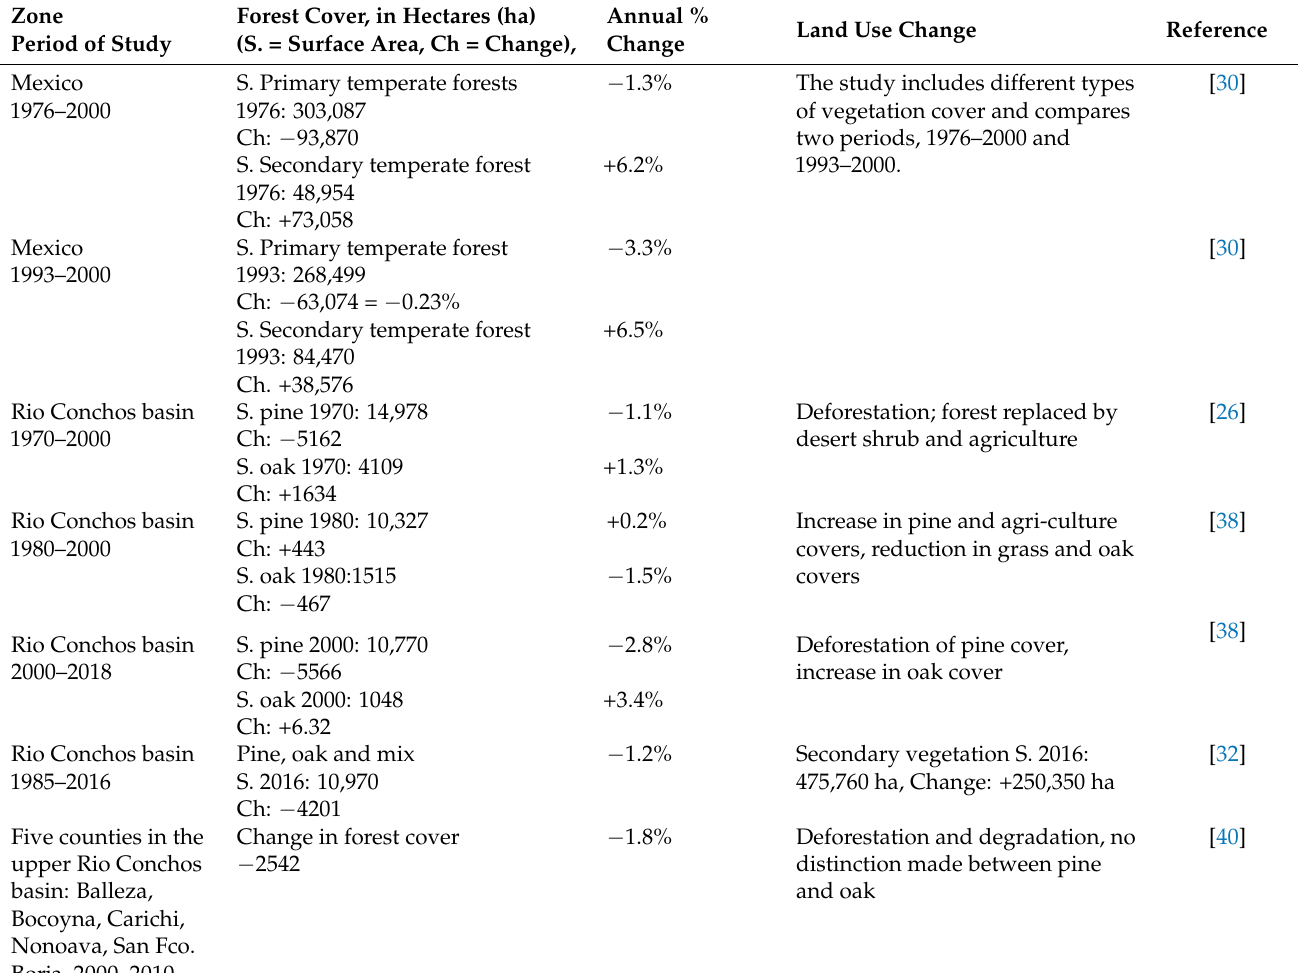
Table 1. Change in forest coverage reported for the Rio Conchos basin. Deforestation rates for temperate forests of Mexico are listed for comparison